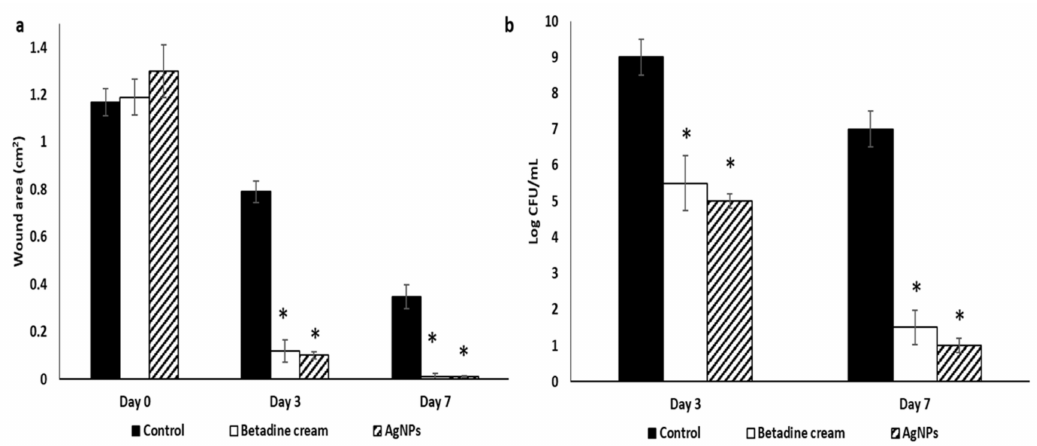
Figure 14. Wound characters on days 0, 3, and 7 in the different rat groups including ( a ) wound area, and ( b ) quantification of CFU/mL. * represents a significant decrease ( p <